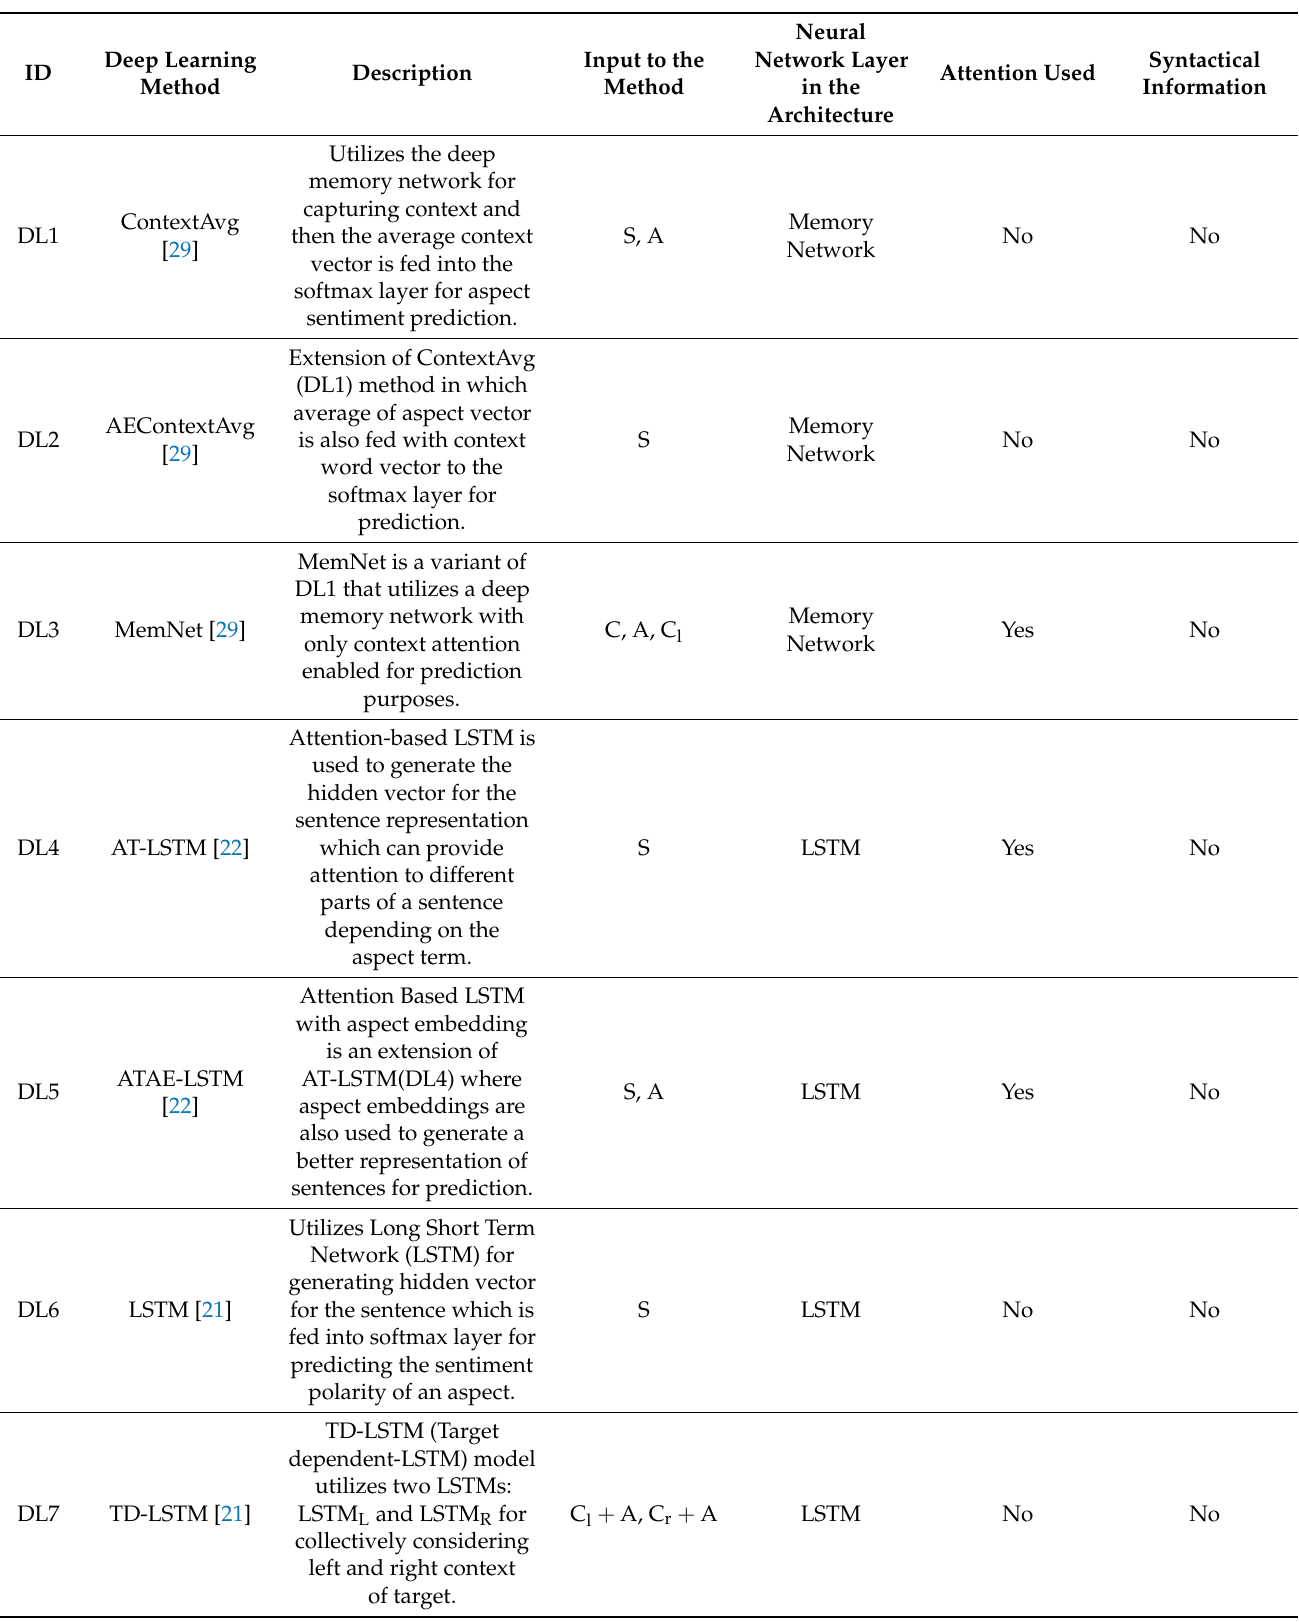
Table 1. Deep learning methods with their